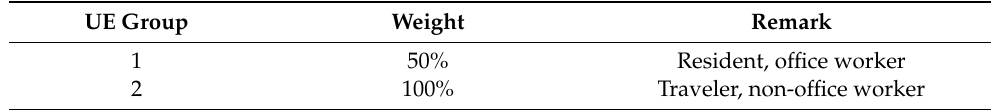
Table 5. Example of weight table of UE